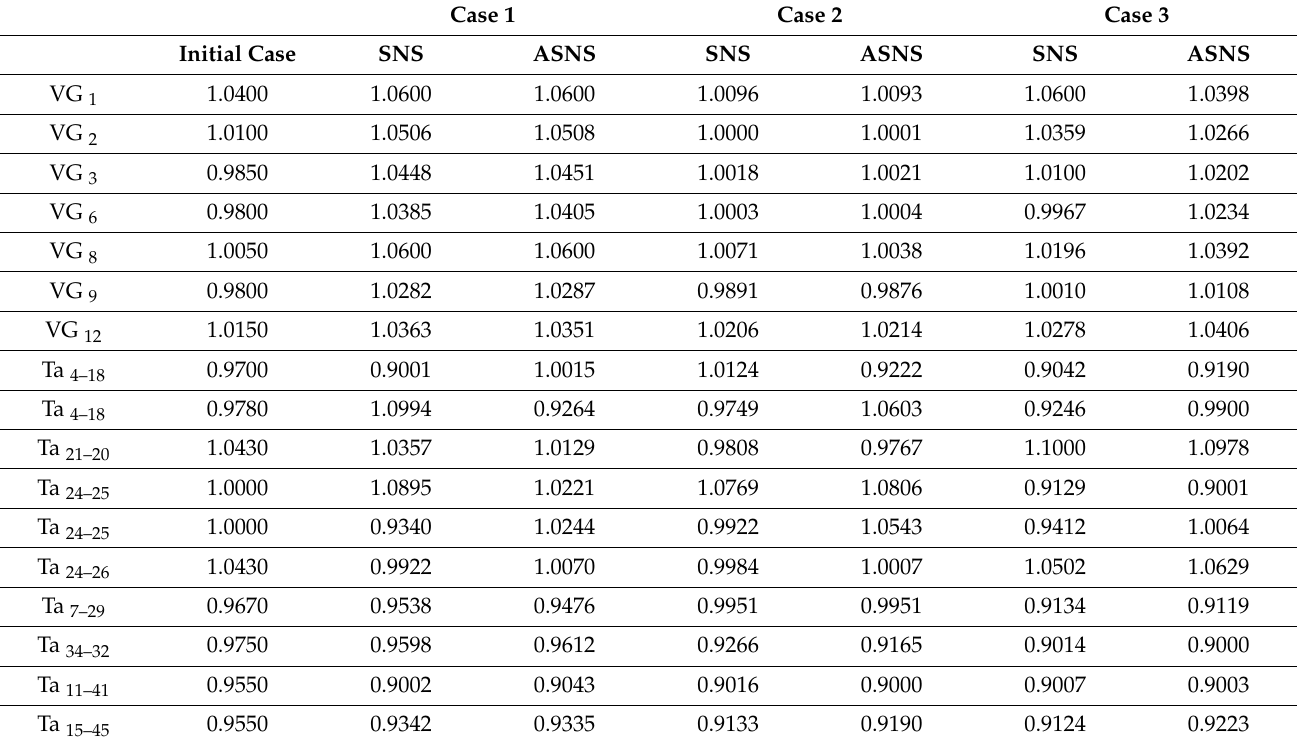
Table 7. Optimal results for Cases 1–3 of the IEEE 57-bus